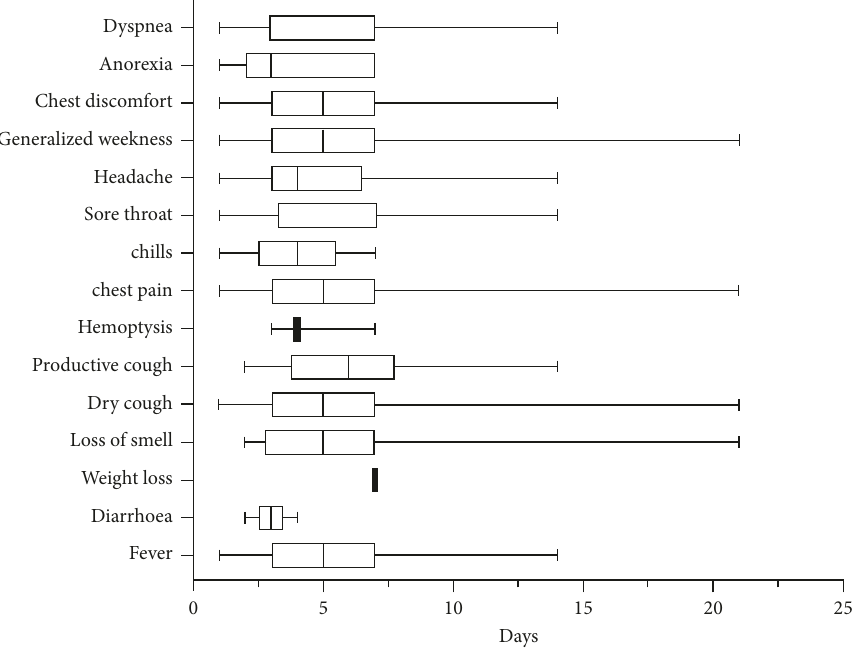
Figure 2: Duration of symptoms among COVID-19 patients at